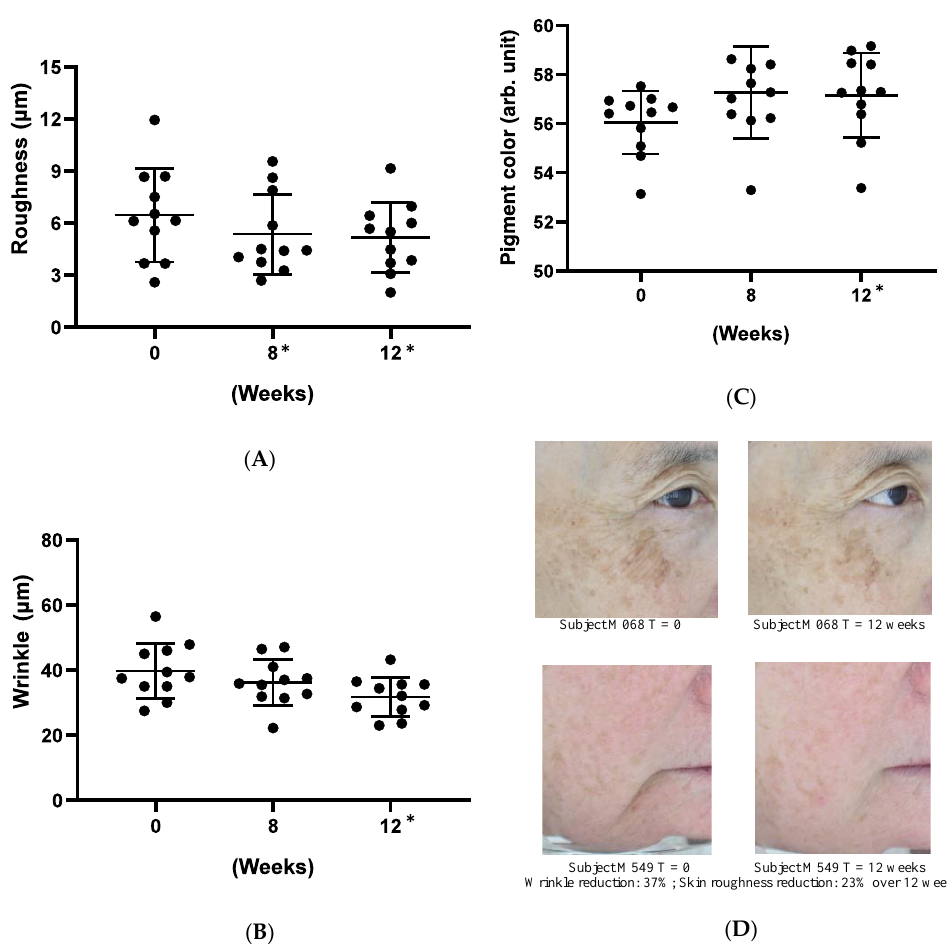
Figure 6. Effect of Officinol™ cosmetic gel on human skins after up to 12 weeks of topical application. Top and bottom bars on each graph represent the standard deviation of the skin condition measurements of all the subjects studied at a specific time point. ( A ) skin roughness (Ra) was reduced by 17% at 8 weeks ( p < 0.05) and 20% at 12 weeks ( p < 0.05). ( B ) wrinkle depth (Ry) was reduced 20% at 12 weeks ( p < 0.05). ( C ) Pigment color scale: white = 100, black = 0. The pigmented area of sun spots (L*a*b* color space) was reduced by 2% at 12 weeks ( p < 0.05). ( D ) Examples of the improvements in skin care conditions captured by digital photographs. * Denotes the weeks when the data collected had statistically significant variance from those obtained at time point